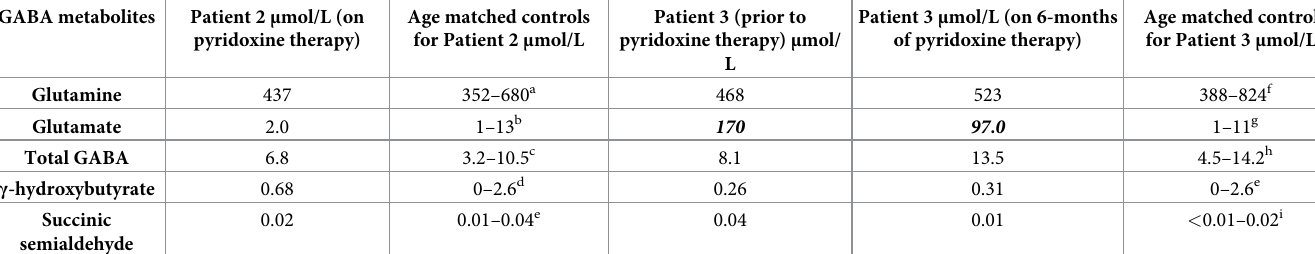
Table 1. GABA pathway metabolites of Patient 2 and Patient 3 with PDE- ALDH7A1 . GABA